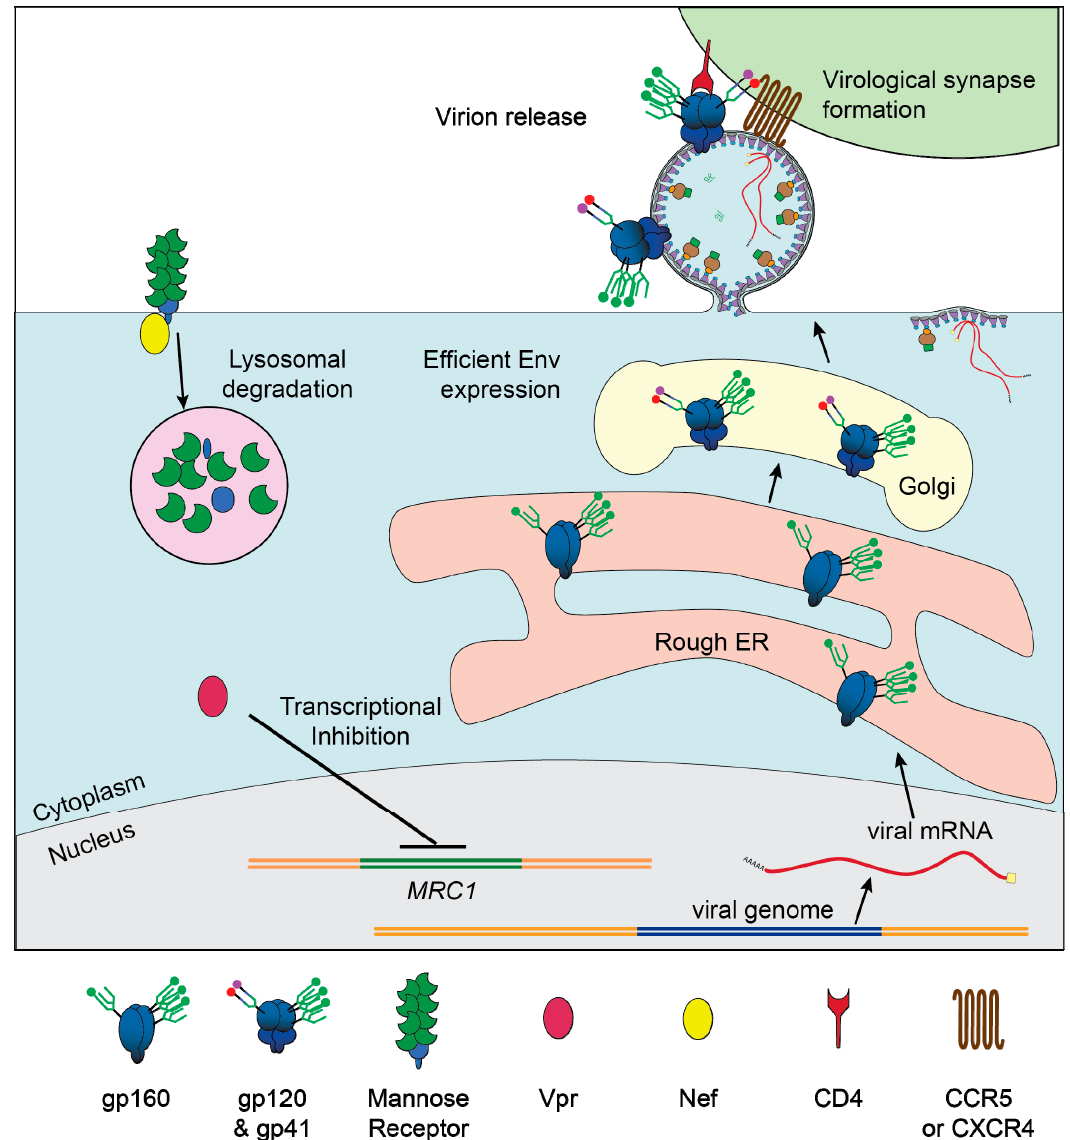
Figure 6. Vpr- and Nef-mediated downmodulation of MR lifts restriction of HIV in macrophages. Graphical depiction of our proposed model in which Vpr reduces transcription of MRC1 , the gene that produces MR, and Nef binds to MR, to remove it from the cell surface. Low MR expression allows for high Env expression, e ffi cient virion release, and formation of virological synapses between infected macrophages and uninfected CD4 + T